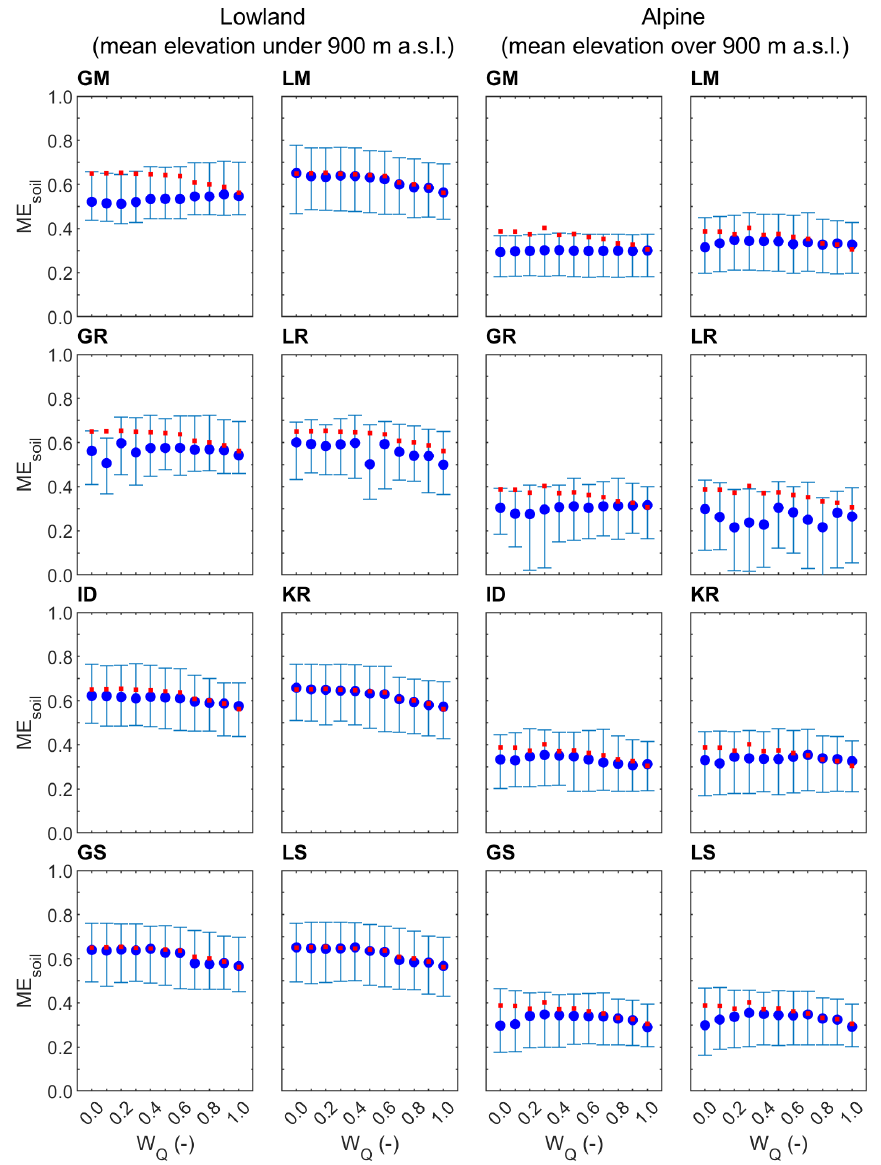
Figure 5. Same as Fig. 4 but for the validation period